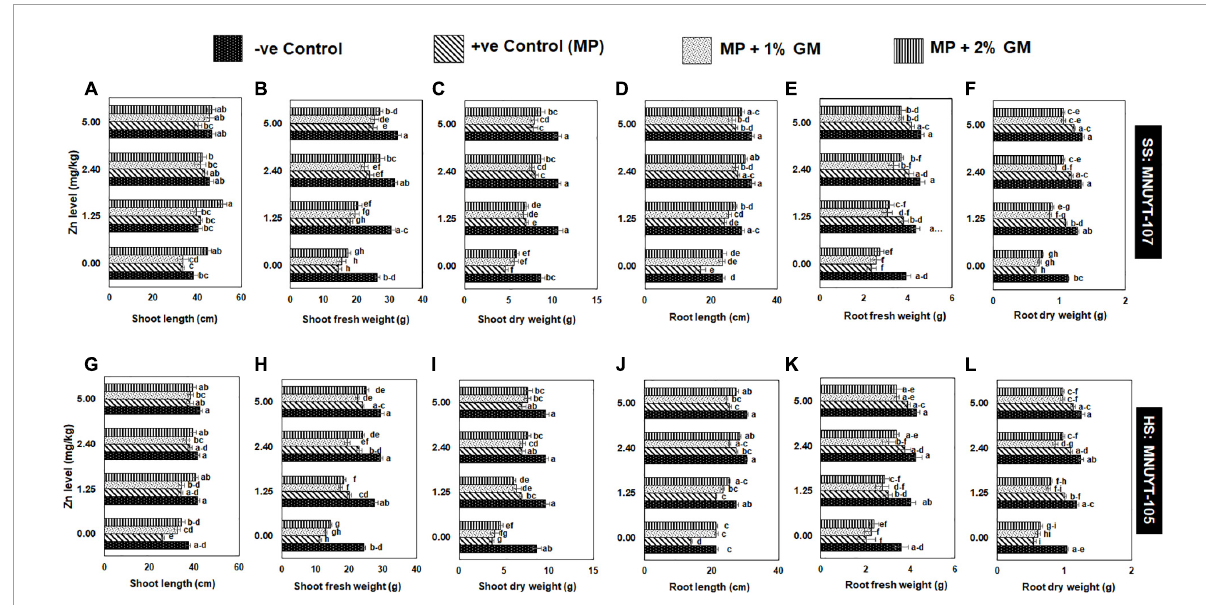
FIGURE2 (A–L) Effect of soil application with zinc (Zn) and green manure (GM) on vegetative growth attributes in susceptible (SS: MNUYT-107) and highly susceptible (HS: MNUYT-105) genotypes of mungbean after 70 days of sowing. –ve control (without pathogen, Zn or GM); +ve control [ M. phaseolina (MP)]. Vertical bars show standard errors of means of three replicates. Means with the same letters are not significantly different at p < 0.05 according to Fisher’s least significant difference (LSD) test.